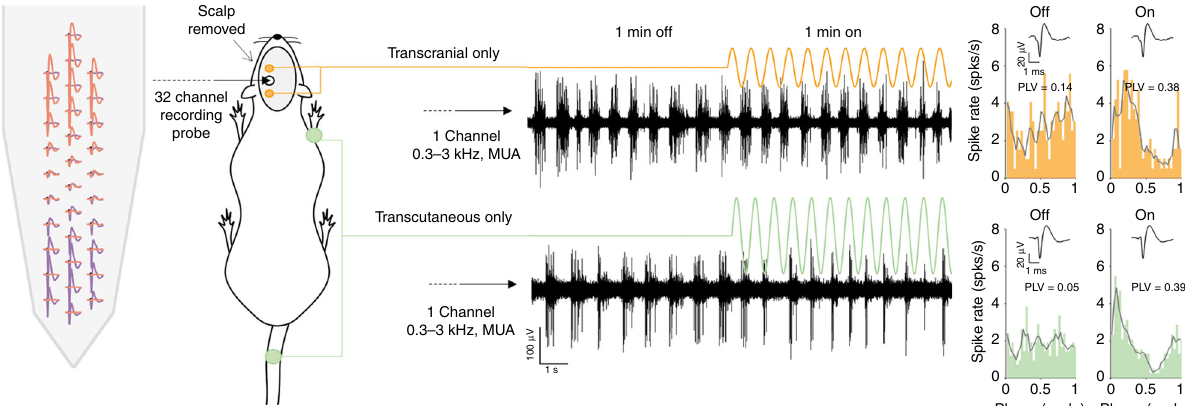
Fig. 2 Setup to study transcranial- and transcutaneous-only stimulation in rat. A 32-channel silicon probe (far left) was inserted into the motor cortex through a burr hole and used to make extra-cellular recordings of slow “ bursting ” multiunit activity (MUA, two example recordings are shown in black). A large section of the scalp was retracted allowing transcranial-only sinewave stimulation to be applied through two micro-screws driven halfway through the skull. The orange line shows transcranial-only stimulation. During the experiment, 2-min recordings of MUA were made to compare 1 min with no stimulation (OFF condition), to 1 min with stimulation (ON condition). Transcutaneous-only stimulation (green line) was also a sinewave applied via crocodile-clip electrodes attached to the rectal temperature probe and the skin on one of the four limbs (contralateral fore shown; contra-hind, ipsi-fore and ipsi-hind were also tested). The same 2-min recordings of MUA with OFF and ON conditions were made for transcutaneous-only stimulation. Automatic (Klusta Suite) followed by manual spike sorting was used to isolate single-unit activity. An example of two single-units recorded from the same site are shown in pink and purple on the 32-channel probe. Single-unit spike times were used to calculate cycle histograms (far right panels) to compare the amount of neural entrainment when no stimulation was delivered (OFF, left column) to neural entrainment during stimulation (ON, right column). Neural entrainment in each condition was quanti fi ed by calculating the phase locking value (PLV, shown on each cycle histogram). The average single-unit spike waveform for each condition is shown as an inset. In this example, both transcranial-only and transcutaneous-only stimulation cause an increase in